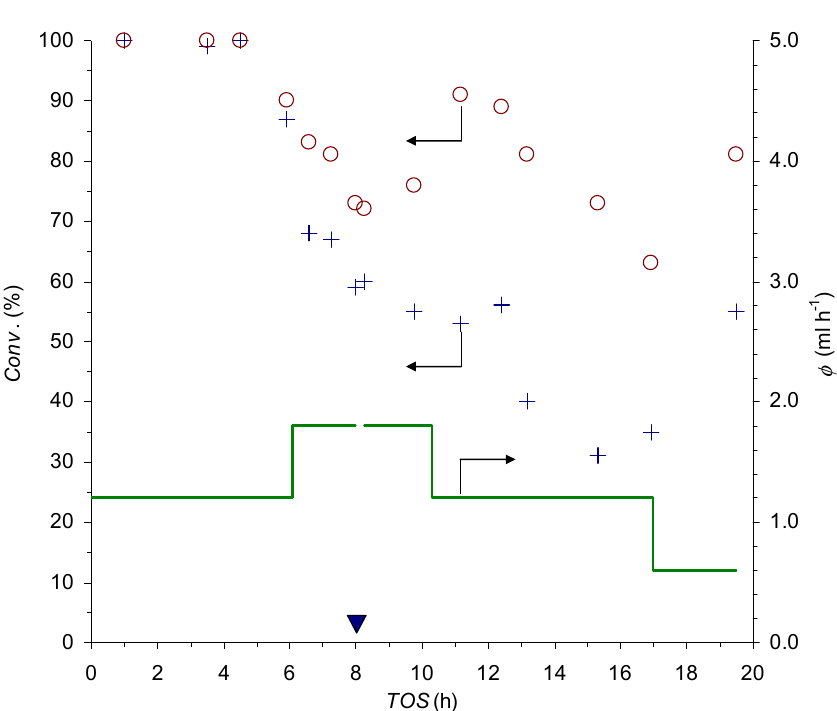
Figure 4. Set flow-rate ф (continuous line) and conversion values at the outlet of PCFRs R1 ( circles ) and R2 ( crosses ) as a function of the time on stream; the filled triangle marks a daily break in the experiment’s course (for the conditions, see Table 3, entries 1 and 3).